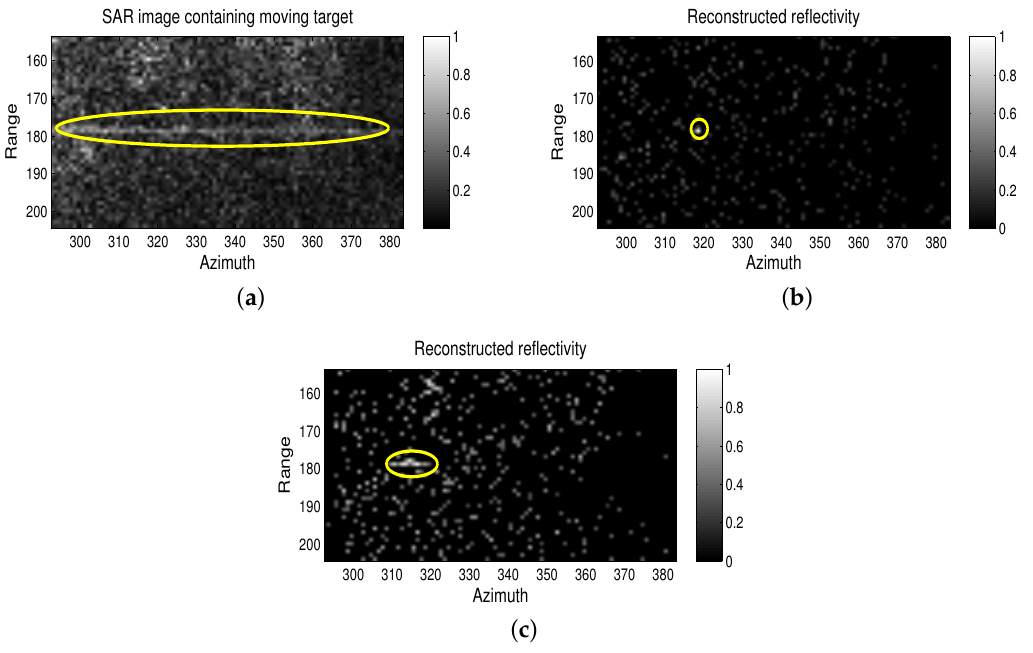
Figure 4. ( a ) SAR image patch in 2D containing moving object: the ellipse highlights the defocusing due to motion; ( b ) reconstructed reflectivity patch in 2D using DGAOMP: the circle highlights the focusing of the moving target compared to the SAR image patch; ( c ) reconstructed reflectivity patch in 2D ignoring acceleration rate: the ellipse shows that the defocusing is more compared to the results with